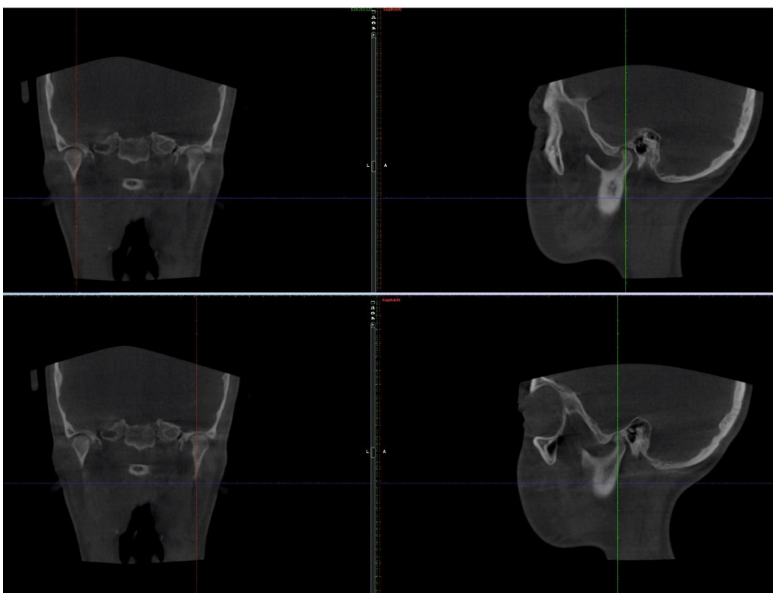
Figure 27. Cephalometric analysis at the one-year follow-up appointment: Roth Jarabak cephalometric analysis ( A ), cephalometric radiograph ( B ), landmarks and reference lines of the cephalometric analysis ( C ). Stability was also noted for the TMJs (Figure 28), with no further pain or discomfort.